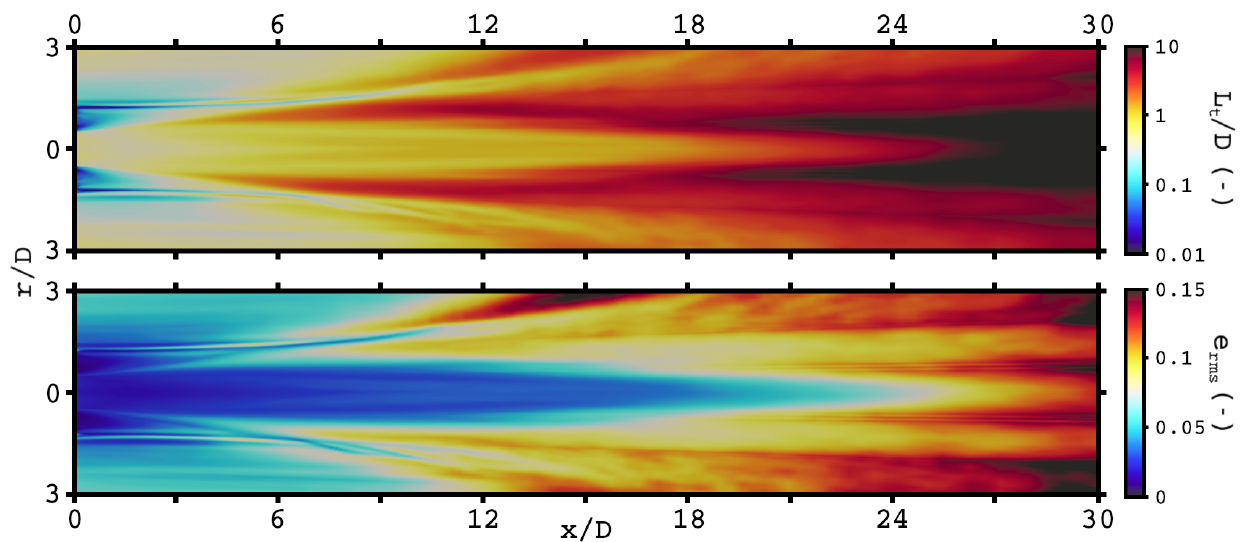
Figure A1. Predicted ( top ) turbulent length scale L t and ( bottom ) sampling error e rms for an averaging time of t av = 0.25s. LES results obtained with eight stochastic fields